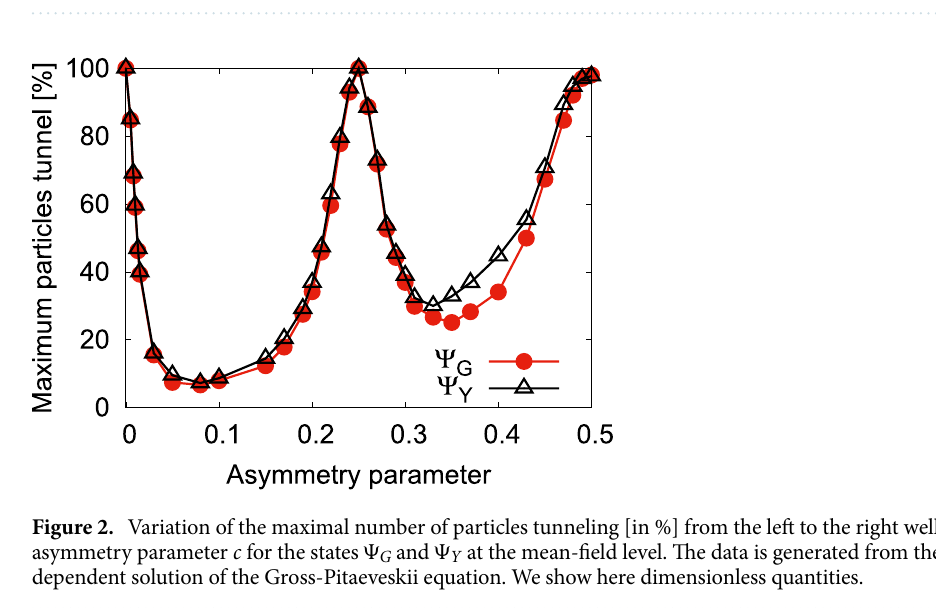
Figure 1. ( a ) Schematic diagrams for the asymmetric 2D double-well potential for longitudinal resonant tunneling, described in Eq. (4). Here the the right well is lower than the left well. Panels ( b ) and ( c ) show the initial density distributions for the ground and transversely-excited states, respectively.